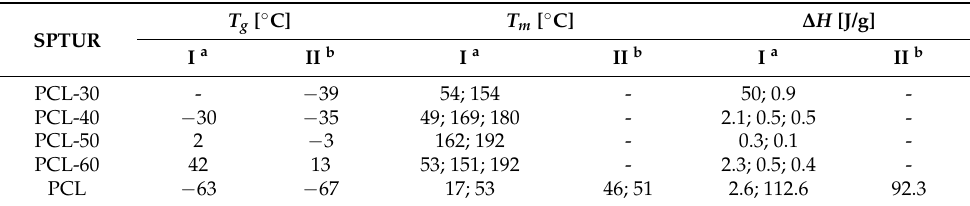
Table 3. DSC data of the synthesized SPTURs and SS.